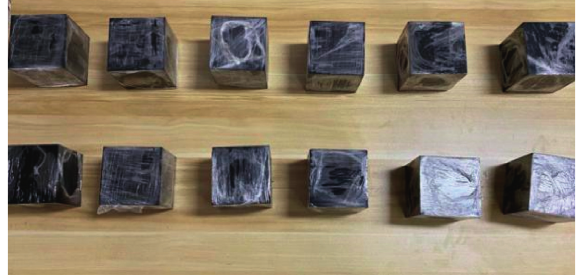
Figure 2: Coal Table 1: True triaxial loading and unloading test data.